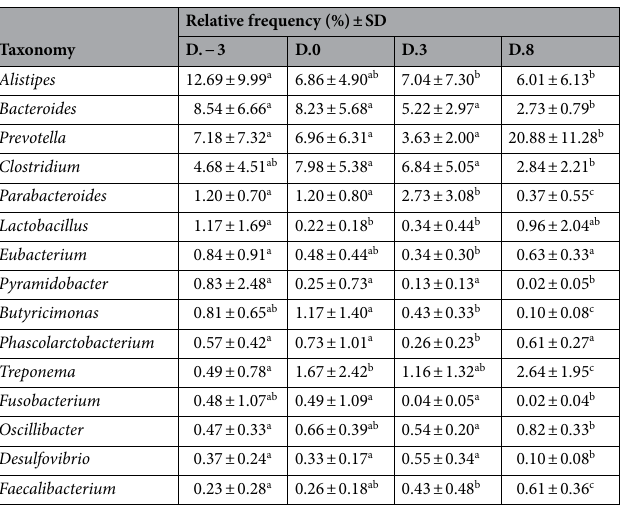
Table 3. Relative abundances of the 10 most abundant genera in each piglet group at day 3 pre-weaning (D. − 3), weaning day (D.0), days 3 (D.3) and 8 post-weaning (D.8). a,b,c A significant difference in the same row at P < 0.05.